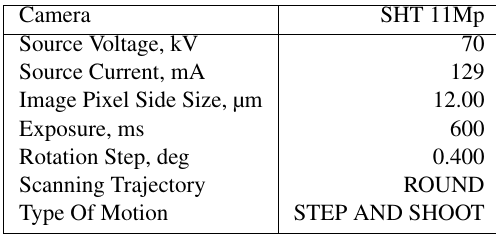
Table 1. Scanning parameters of